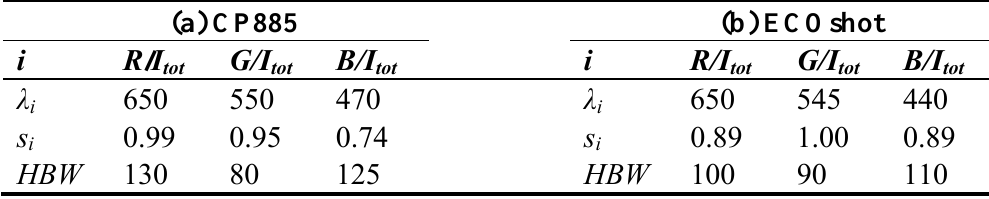
Table 1. Centre wavelength λ of band i , regarding spectral response values RGB /( R + G + B ) (Figure 3), of digital